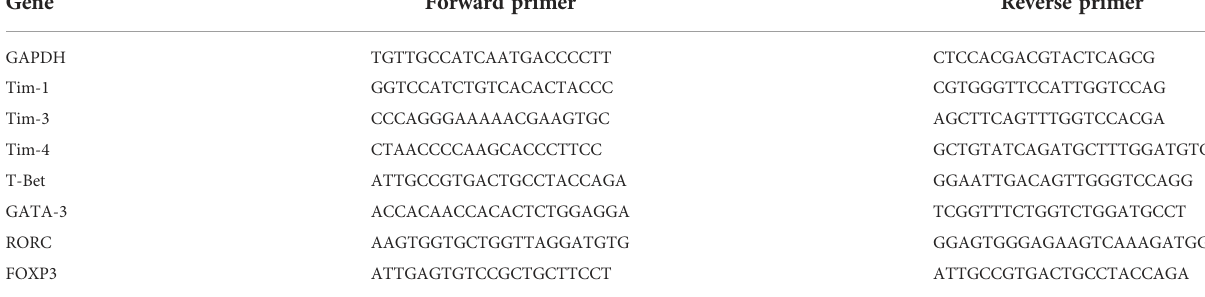
TABLE 2 Forward and reverse primers for the RT – PCR experiments in this study. Gene Forward